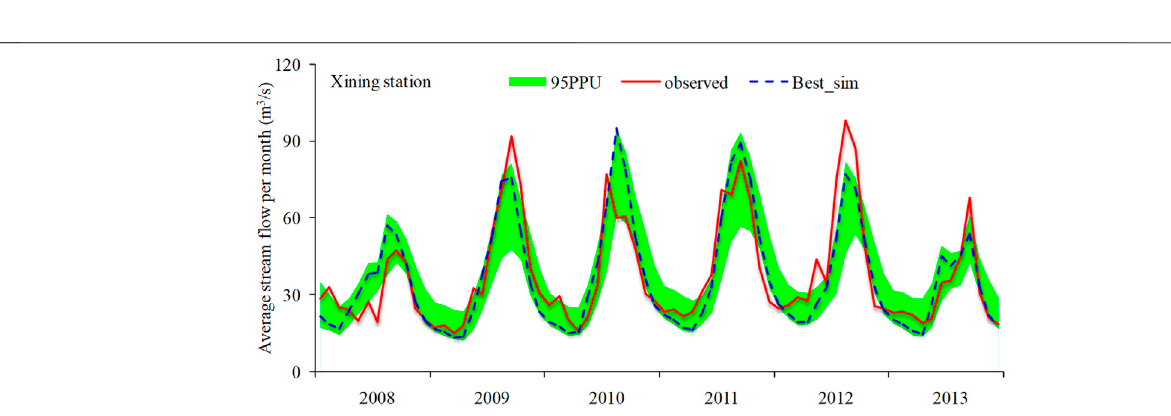
FIGURE 8 | The monthly precipitation predictions and the observed precipitation data.